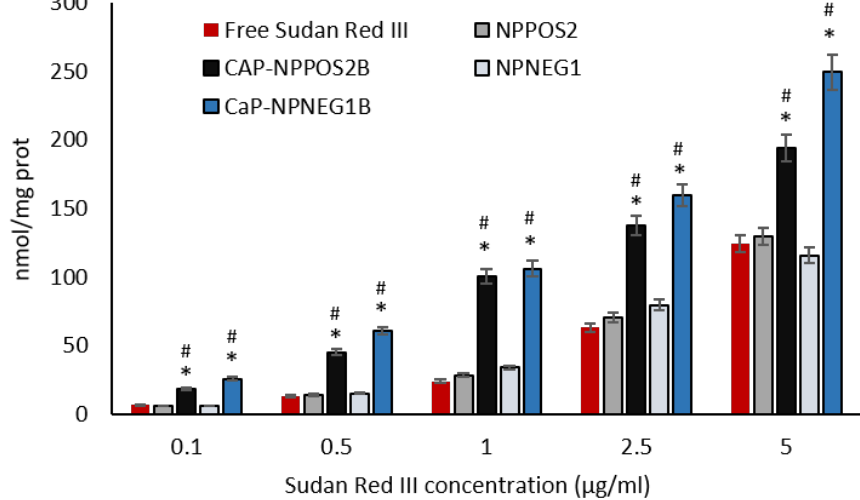
Figure 10. Uptake of Sudan Red III in human osteosarcoma cells after 24 h. Data are expressed as mean + SD (n = 3), * p < 0.05 vs. free Sudan Red III; # p < 0.05 vs. NP POS 2/NP NEG